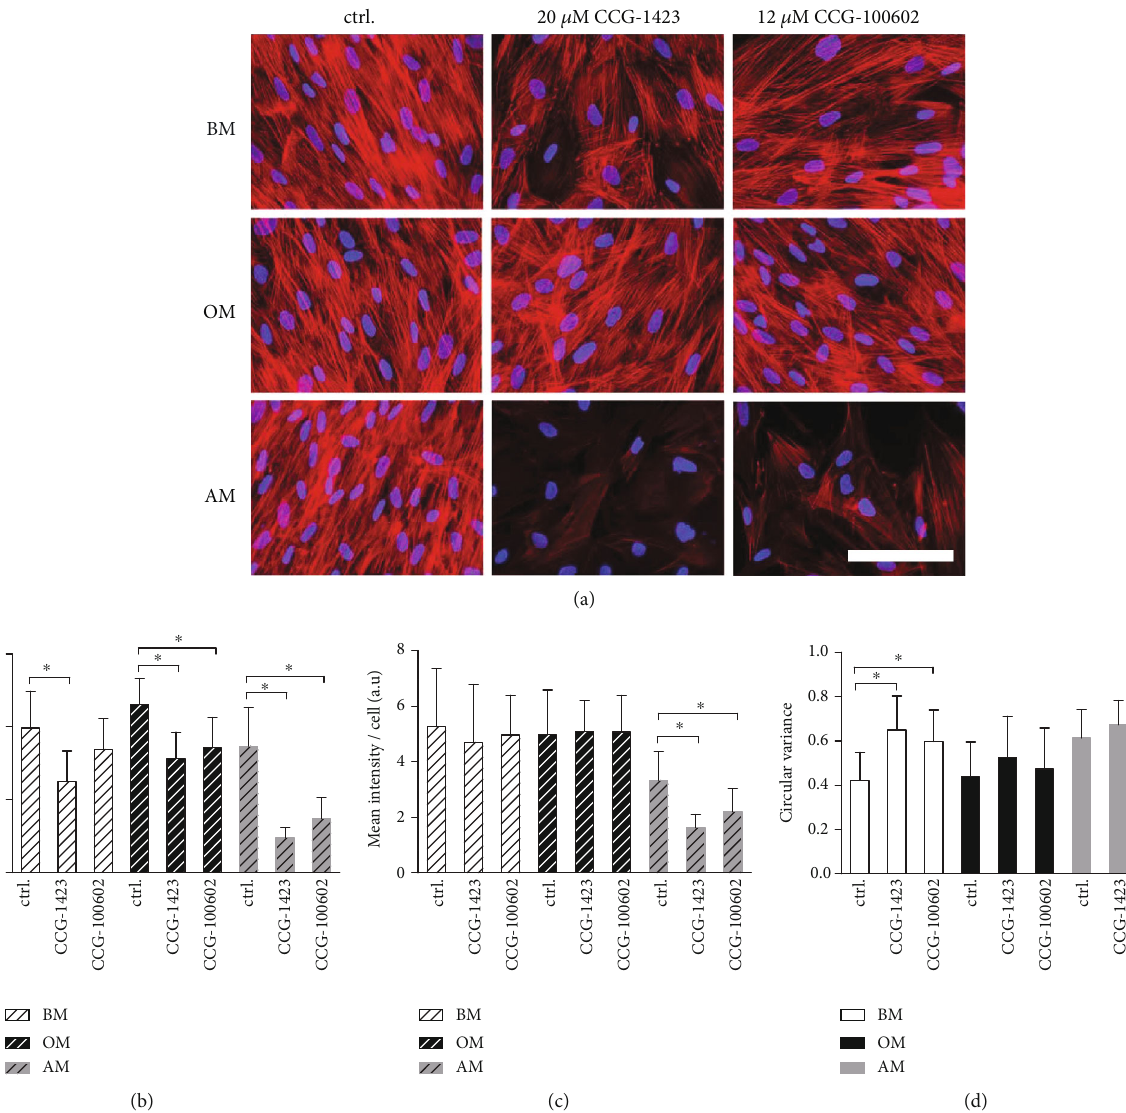
Figure 6: F-actin intensity and orientation of MRTF-A inhibitor-treated hASCs. hASCs were cultured 7d in BM, OM, or AM media supplemented with 20 μ M CCG-1423 or 12 μ M CCG-100602. (a) Representative images of Phalloidin- and DAPI-stained hASCs imaged with Alexa 546 for actin (red) and DAPI for nuclei (blue) fi lters using 40x magni fi cation and constant exposure time. Scale bar 100 μ m. Image-based analysis done with Fiji of mean Phalloidin intensity (b) and mean intensity normalized with nuclei number (c) of the samples described in (a). N = 18 ‐ 25 images, 4 independent biological replicates from 2 donors. Signi fi cance level 5%. (d) Image-based analysis of actin orientation done with CytoSpectre 1.2 spectral analysis tool. Phalloidin-stained hASCs were imaged with 20x magni fi cation and optimally adjusted exposure times from the same biological replicates as above (representative images in Figure S4). N = 16 ‐ 27 images. Signi fi cance level 5%. BM: basic medium; OM: osteogenic medium; AM: adipogenic